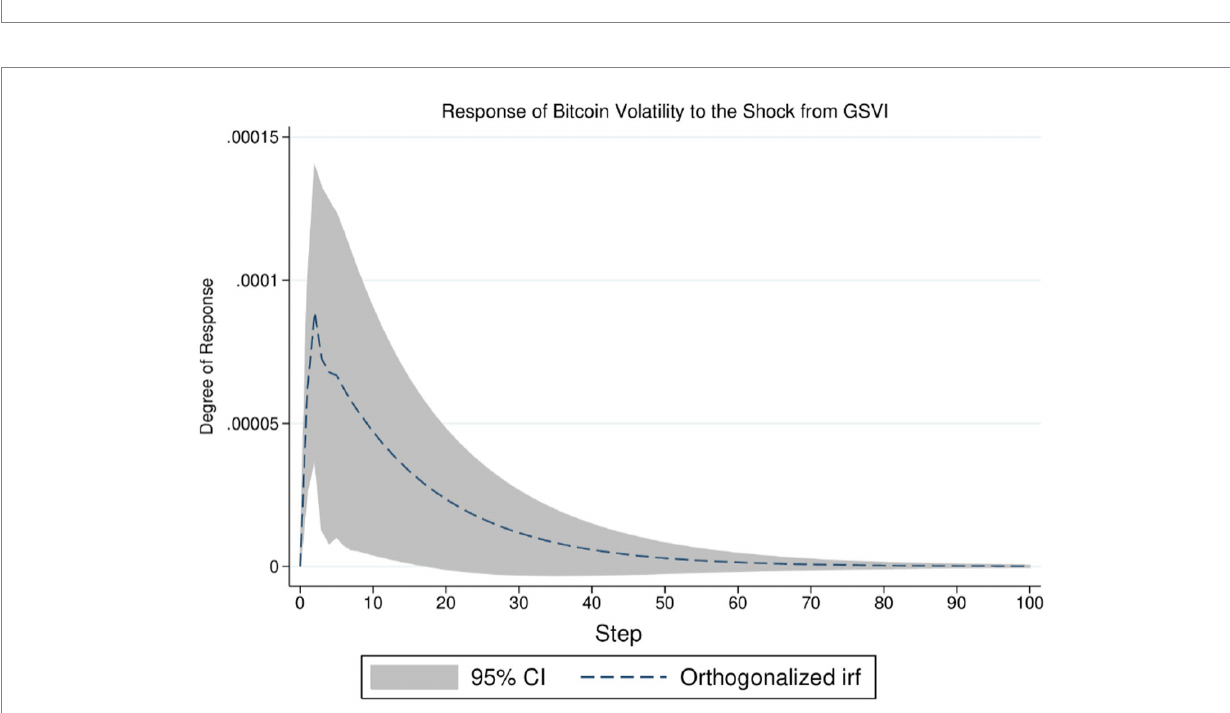
FIGURE 4 Response of Bitcoin volatility to the shock from